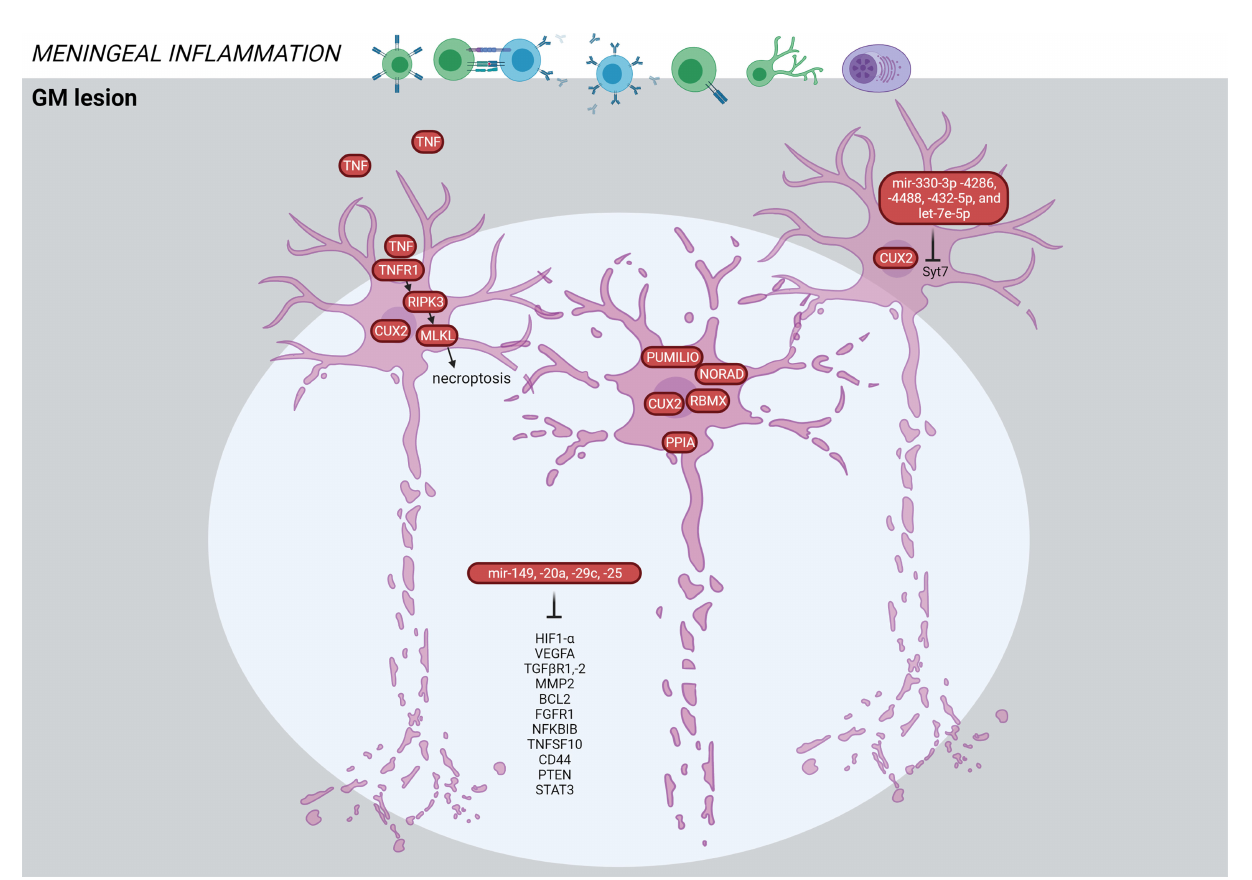
FIGURE 7 | Signature of the GM lesion in the MS brain based on transcriptome and proteome studies. GM lesions are characterized by neuronal death mediated through TNF signaling. The CUX2-expressing cells are particularly vulnerable for degeneration. Alterations in microRNAs have been detected in the GM lesions associated with cortical atrophy. The fi gure was created by compiling data from several articles, and therefore molecules may not be expressed at the same time. Created with